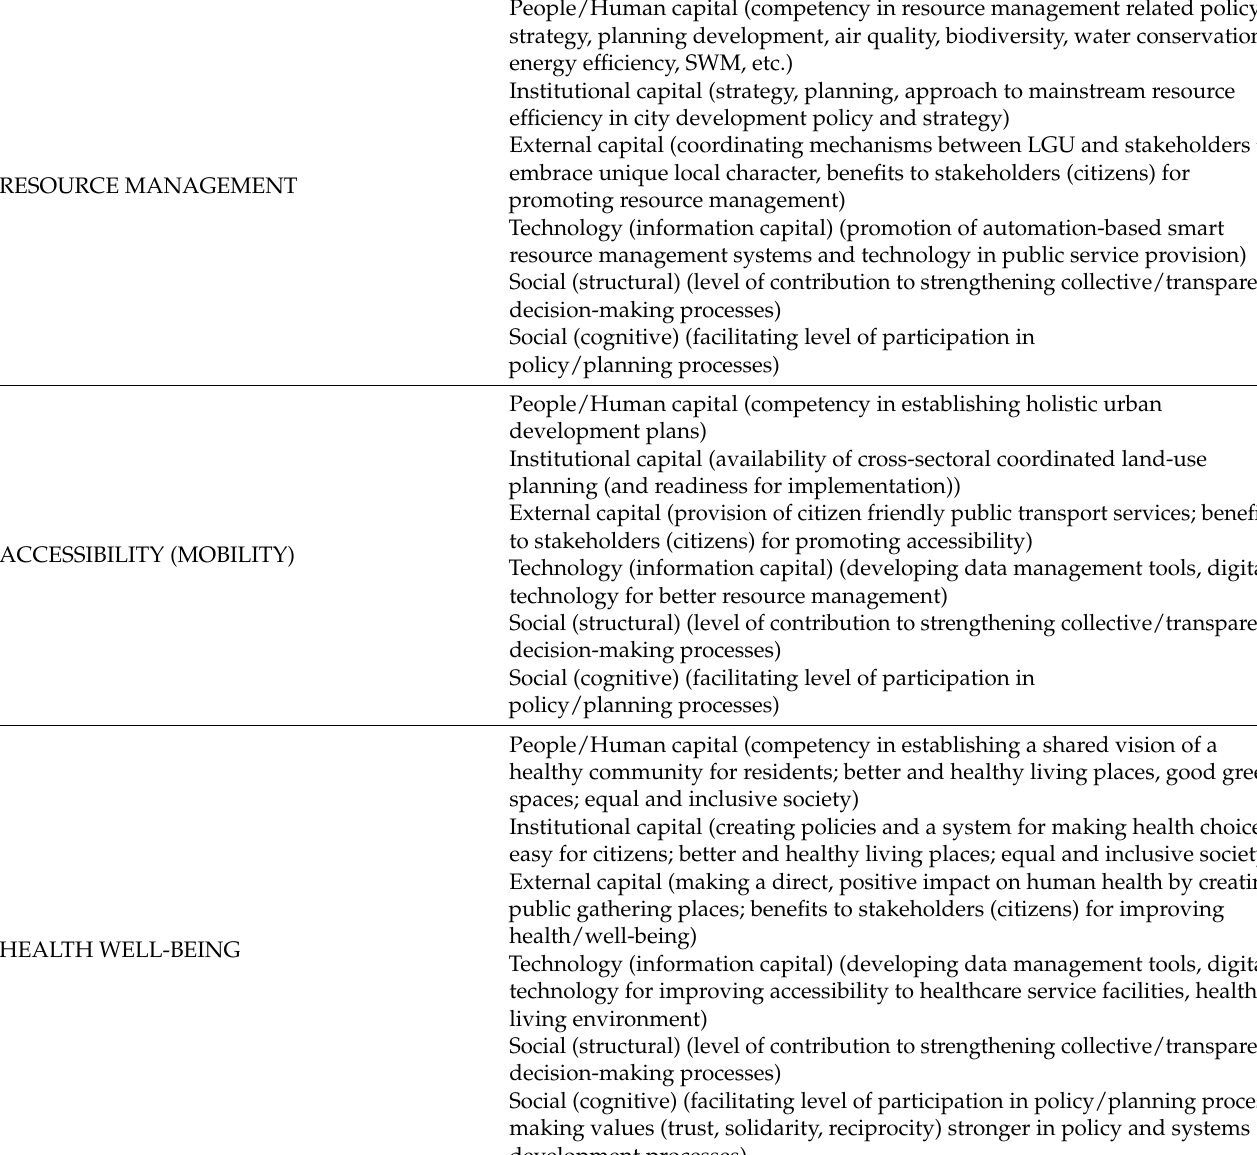
Table A1. Identification of Soft Asset